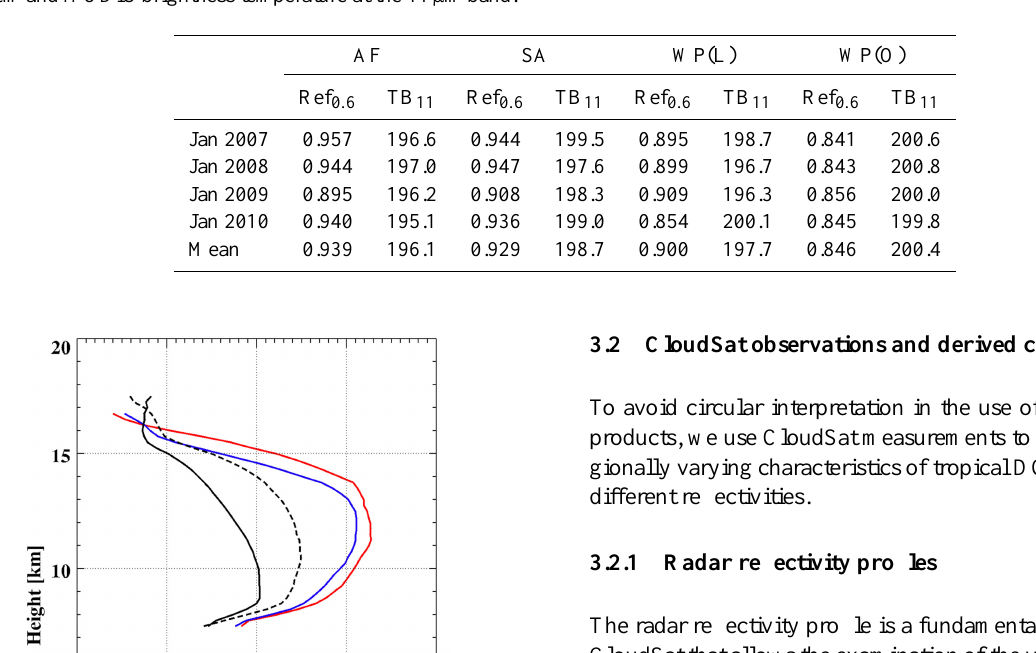
Table 2. Mean Ref 0 . 6 and TB 11 of selected DCC pixels for the four domains. Ref 0 . 6 and TB 11 represent the MODIS reflectivity at the 0.645µm and MODIS brightness temperature at the 11µm band.